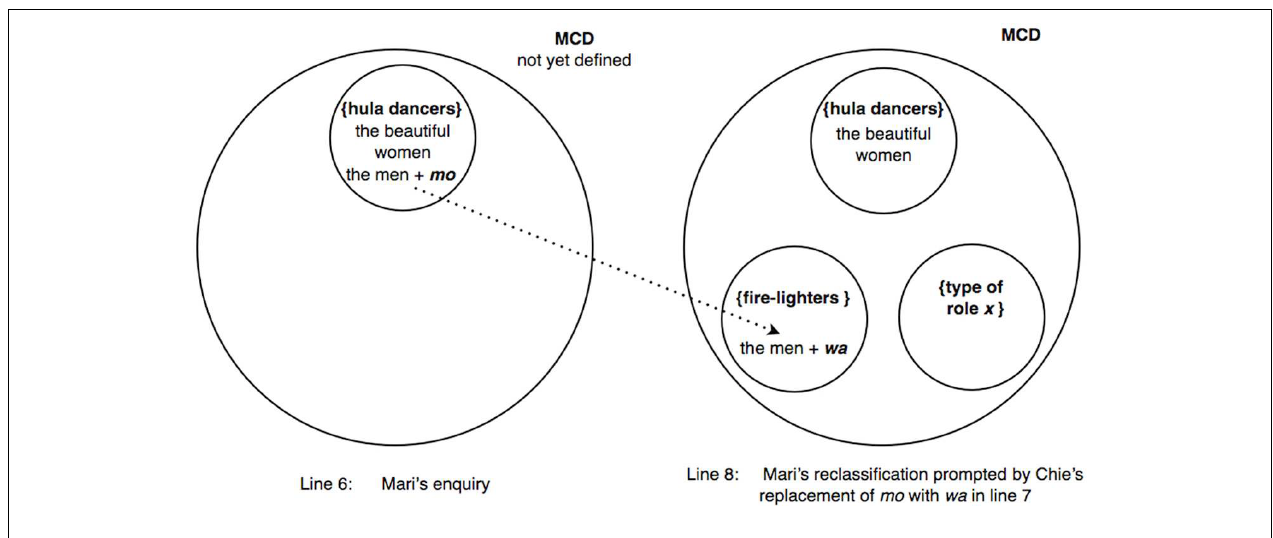
FIGURE 3 | Excerpt (6): Mari marks “the men” with mo to enquire if they belong to {hula dancers} (left); subsequently, Chie’s marking of “the men” with wa prompts Mari to exclude them from {hula dancers} and to reassign them instead to